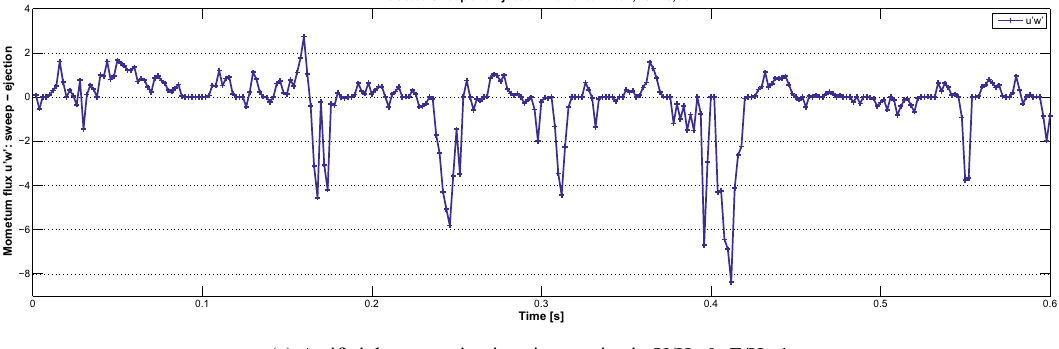
(a) Artificial sweep-ejection time-series in X / H = 0, Z / H = 1.